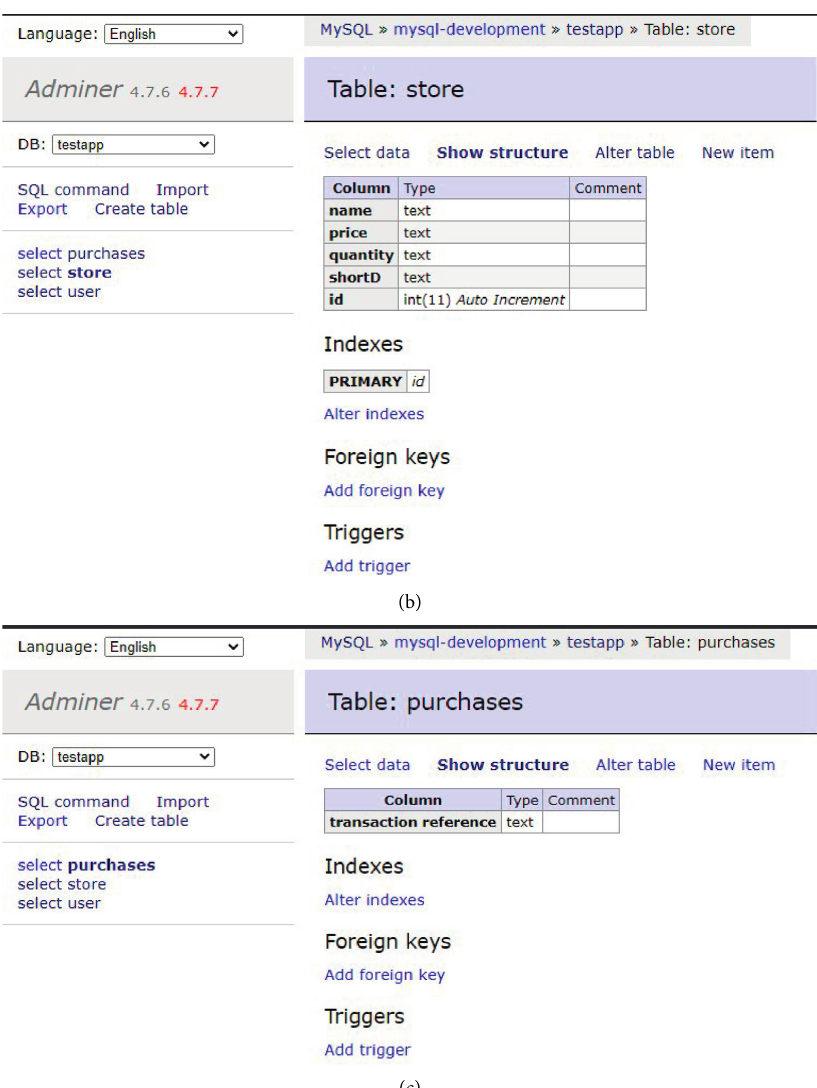
Figure 7: (a) Database structure table for admin users. (b) Database structure table for store items. (c) Database structure table for purchases